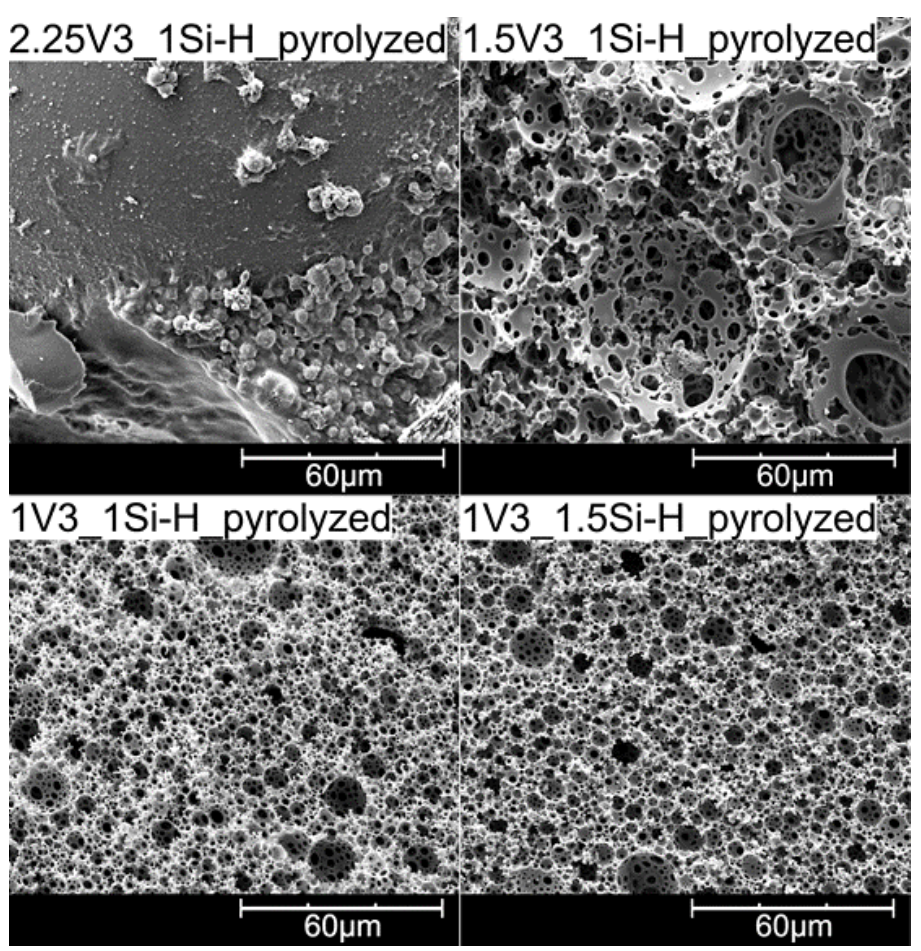
Figure 1. SEM micrographs of polyHIPE materials pyrolyzed at 1000 °C in Ar atmosphere.